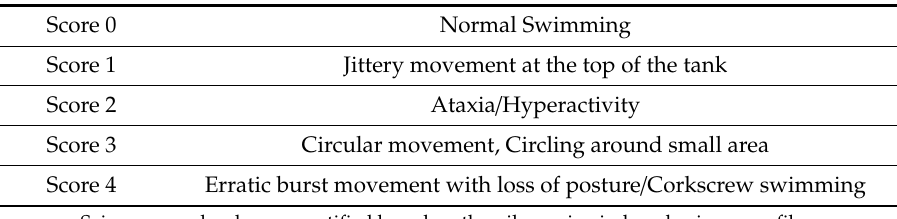
Table 1. Proposed seizure scoring for pilocarpine-induced seizure.